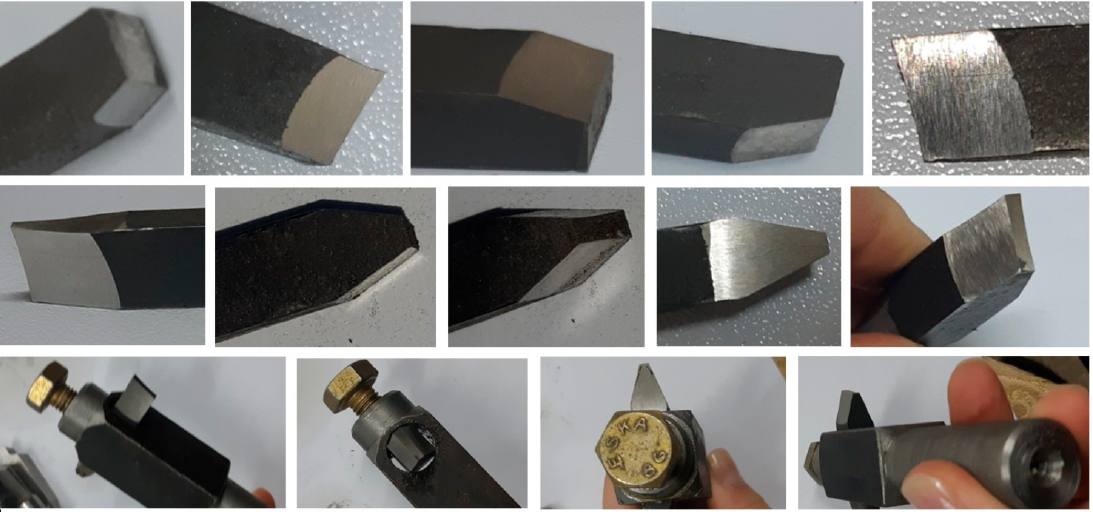
Figure 6. Shape evolution at the mortise knife manufacture.